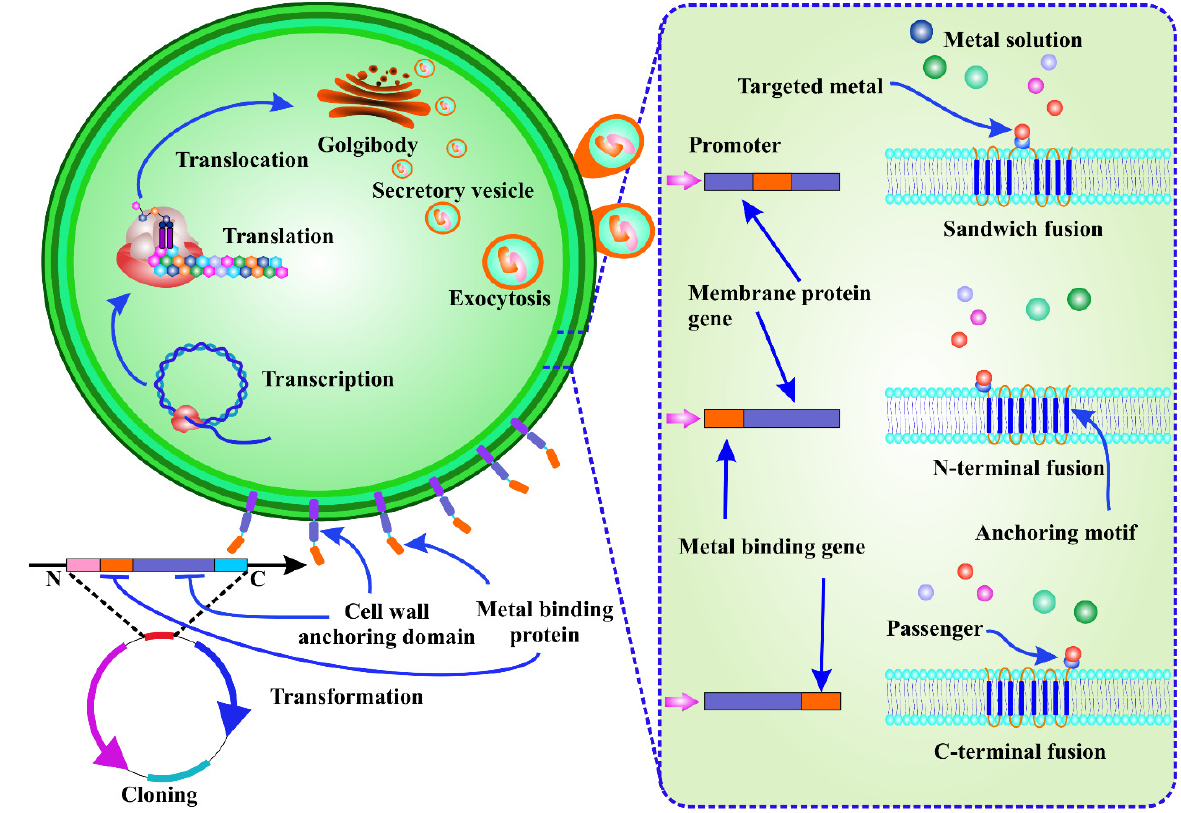
Figure 3. Cell surface engineering for the biosorption of a target metal. It involves the expression of a passenger protein on the cell surface by translational fusion with a carrier protein, which allows the passenger protein to be exported to the cell membrane and anchored to the cell surface. After transcription, translation, and translocation, the metal-binding peptide can be seen as a fusion of an anchor protein.